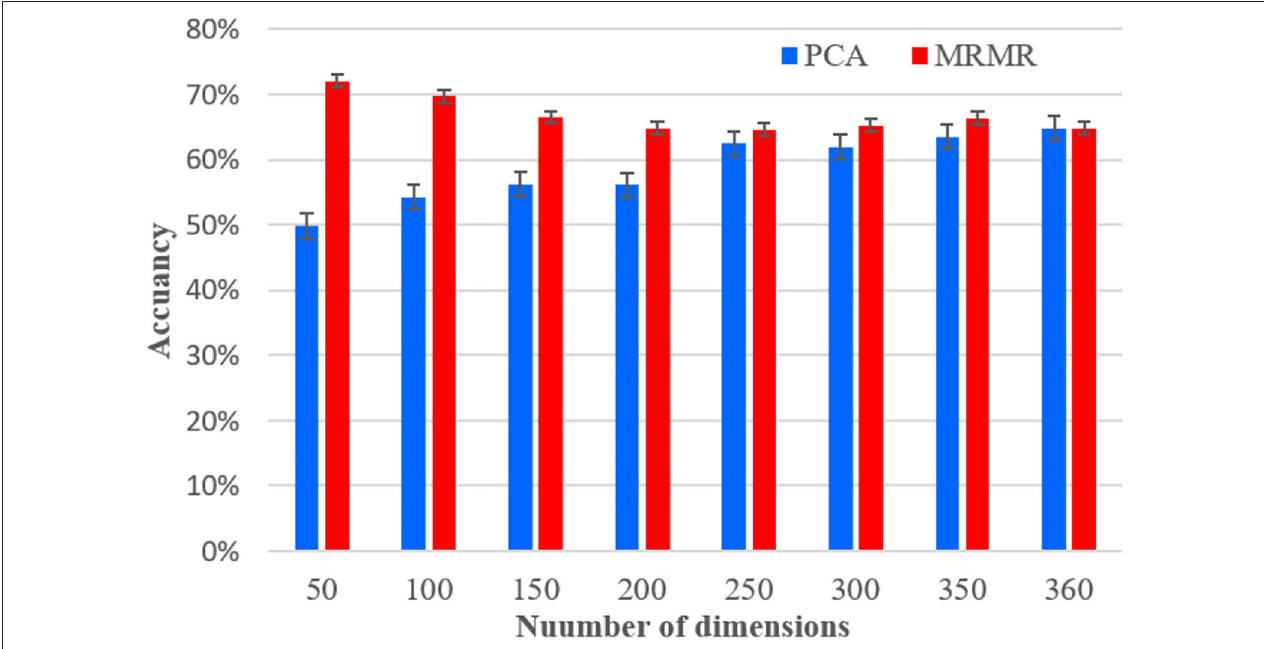
FIGURE 8 | The average accuracies of SVM using RASM_ Hjorth obtained from total frequency bands base on PCA and mRMR for subject